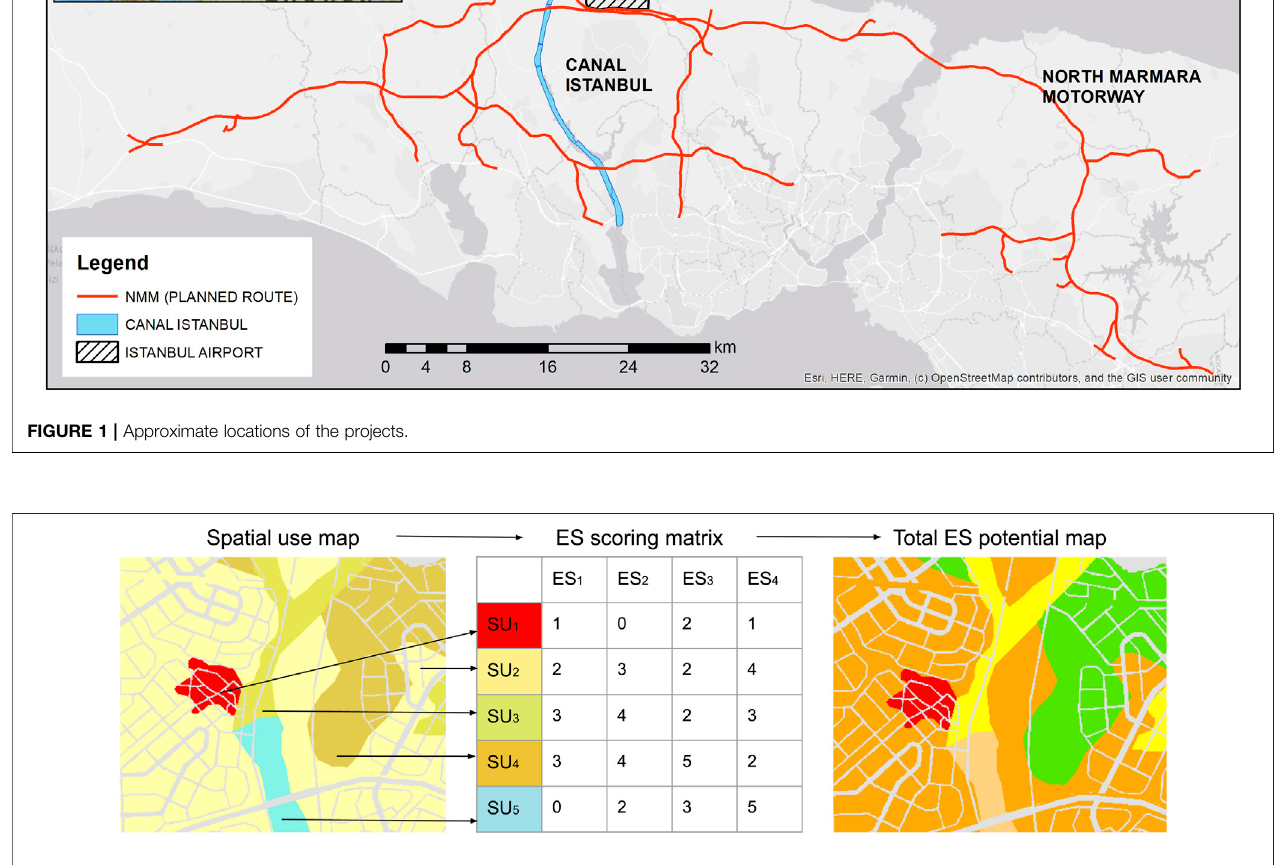
Frontiers in Environmental Science |